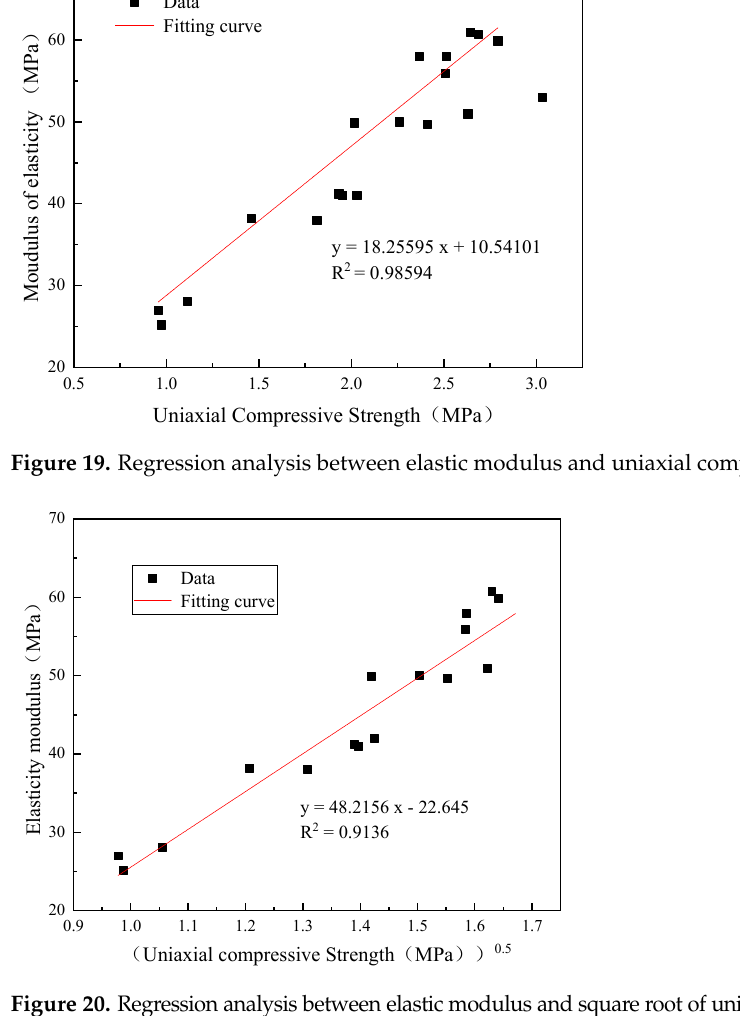
Table 3. CPB strength data under different curing temperatures (MPa). Temperature Time ＋ Figure 21. The structure of the CPB strength prediction model under the influence of different tem- peratures. Figure 22 and Table 4 show the comparison between the measured and predicted values of strength. It can be seen from Table 4 that the maximum absolute error between the measured value and the predicted value was 0.592 MPa, the average absolute error was 0.084 MPa, the maximum relative error was 24.5%, and the average relative error was